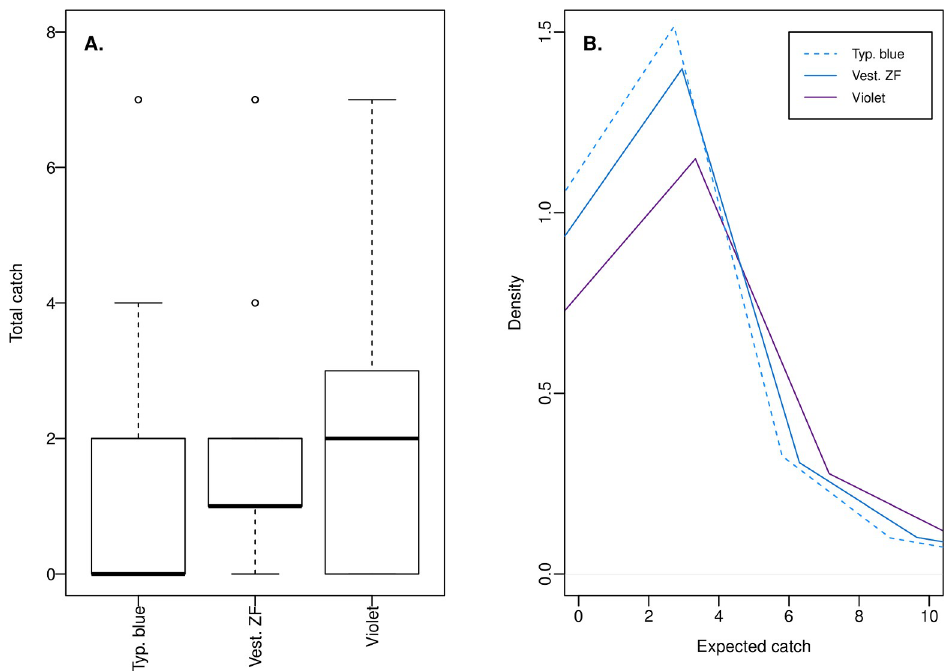
Fig 3. Recorded and posterior predicted G . f . fuscipes catches based on the experiment in Uganda. (A) The distribution of recorded tsetse catches across the three target fabrics tested. (B) Probability density functions for 10,000 expected catches for the same targets, computed using posterior probabilities of model coefficients from a Bayesian model of catches in panel A. Predictions are from the zero-inflated model and exclude zero catches modelled to result from a binary logistic process independent of target type. Boxes in panel A indicate the 25 th , 50 th , and 75 th percentiles; whiskers extend to the most extreme value, or to 1.5 � IQR with more extreme values plotted as points. Sample sizes are 17 catch observations for Vest. ZF and violet, 16 for typical blue. In panel B, note that sampling variation across new intercepts for day, site, and replicate has considerable effect on the shape of the plotted functions, but not the medians and performance comparisons stated in